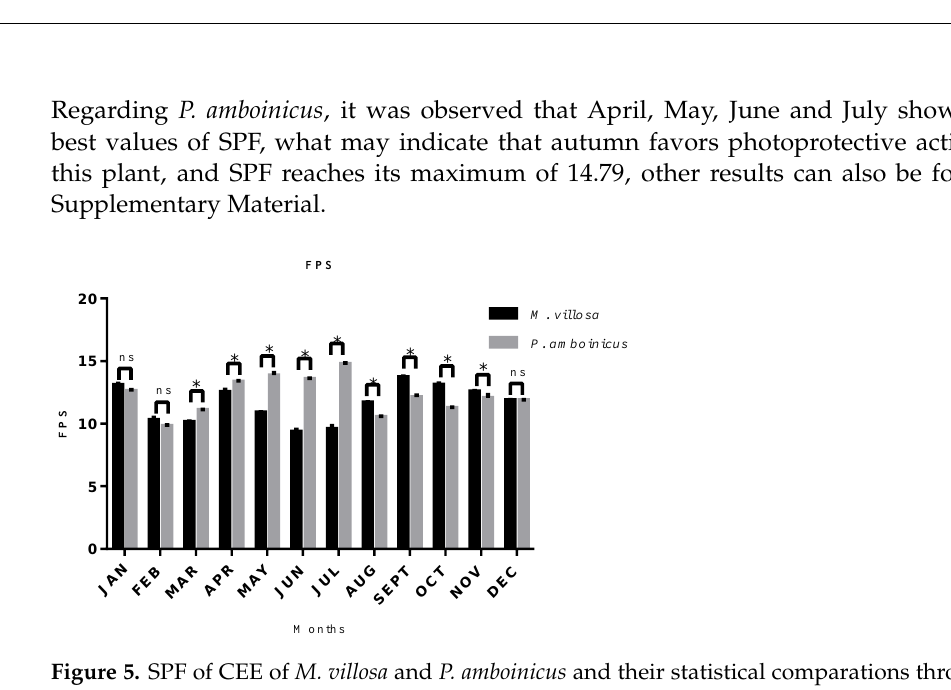
* Figure 4. CEE of M. villosa and P. amboinicus EC 50 in µg/mL and their statistical comparations throughout 12 months. ns = nonsignificant. * statistical difference